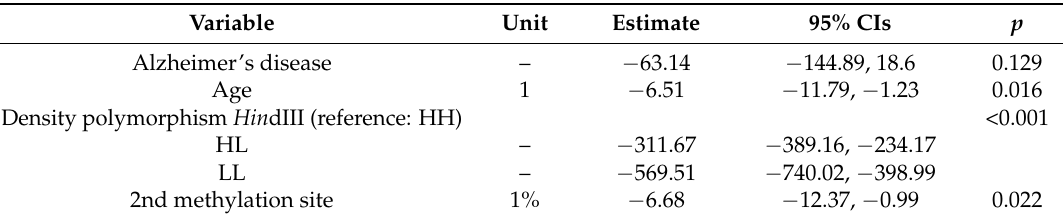
Table 3. Multivariate analysis of factors associated with density.